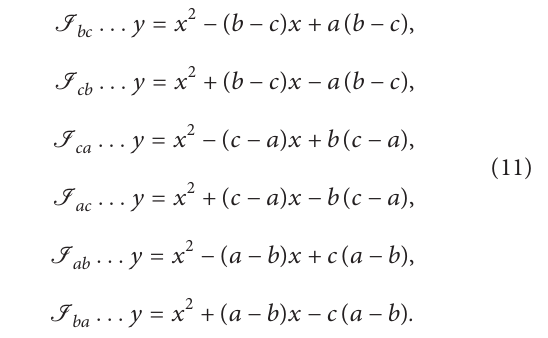
G G a , b , and c of an allowable triangle